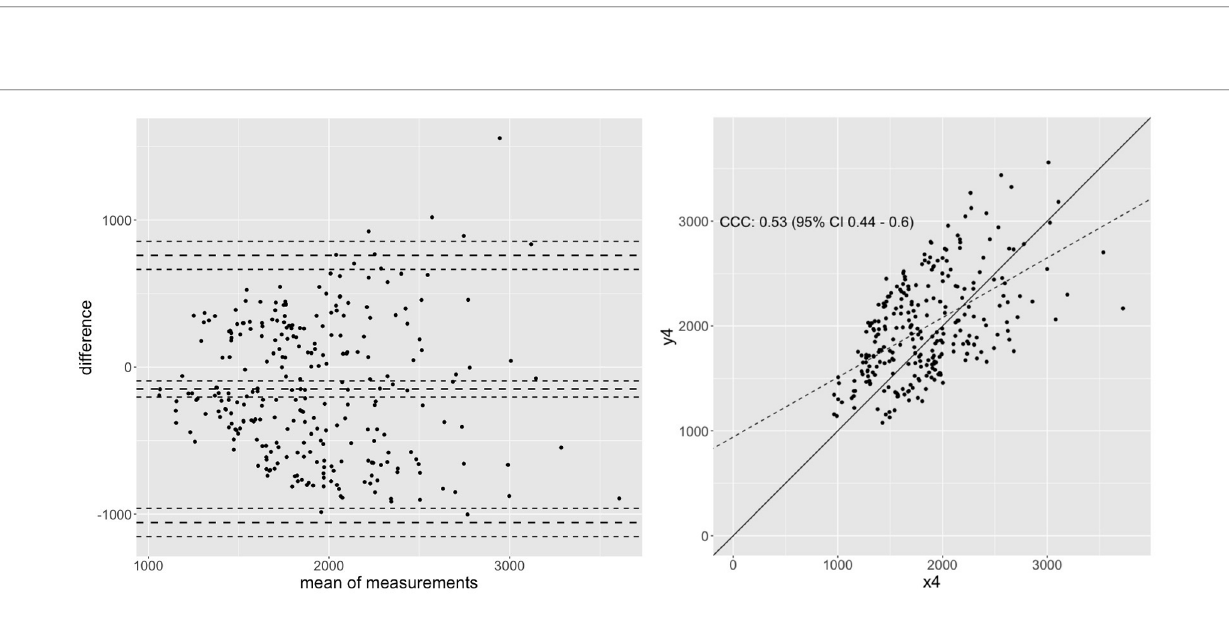
FIGURE 3 An exemplary dataset to calculate the concordance correlation coef fi cient (CCC) of 0.53 with n =273 showing moderate Pearson correlation with r =0.55, representing magnitude of correlation usually found between dynamic and isometric